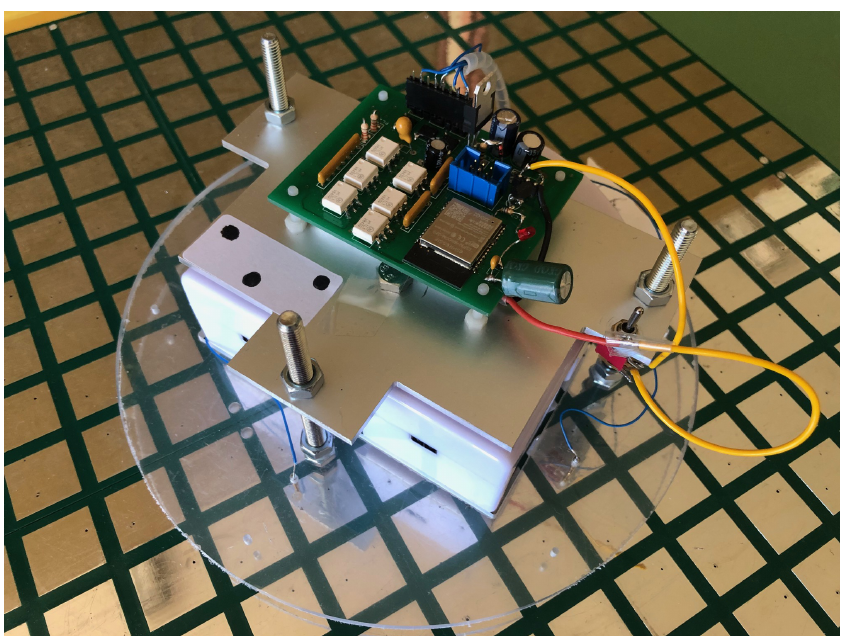
Figure 7. Picture of the mobile robot positioned on the power floor. At the basis of the robot a Plexiglas disk can be seen; the 5 contact pins are positioned along its circumference. On top of the robot, the power supply and localization electronics can be seen. A white label with three black dots serves as a marker for the robot’s pose measurement system—we employed a computer vision system, placed above the floor, to validate the results of the experimental